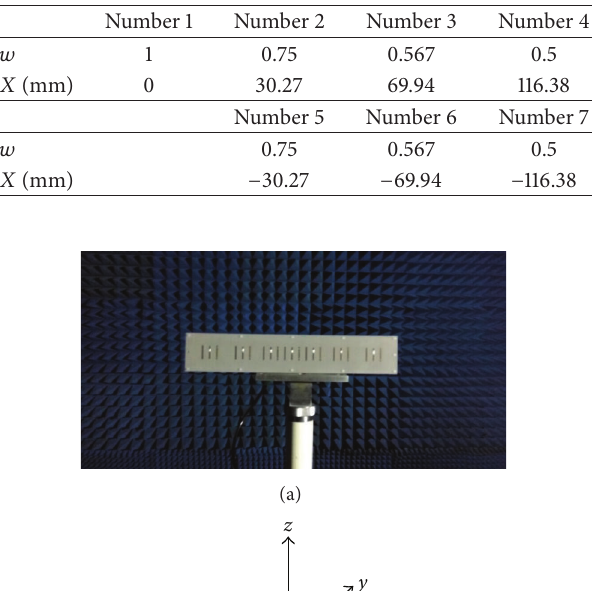
Table 2: Position and amplitude of the elements.